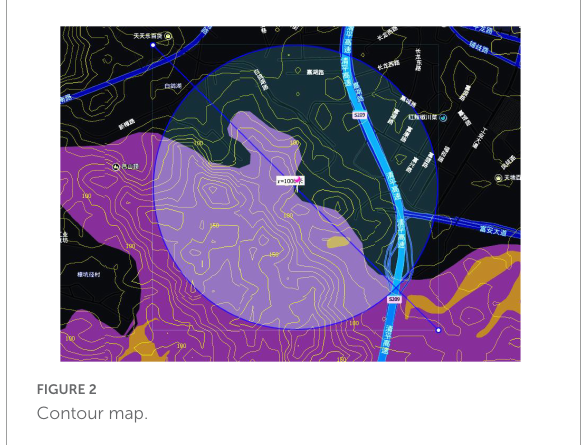
FIGURE2 Contour